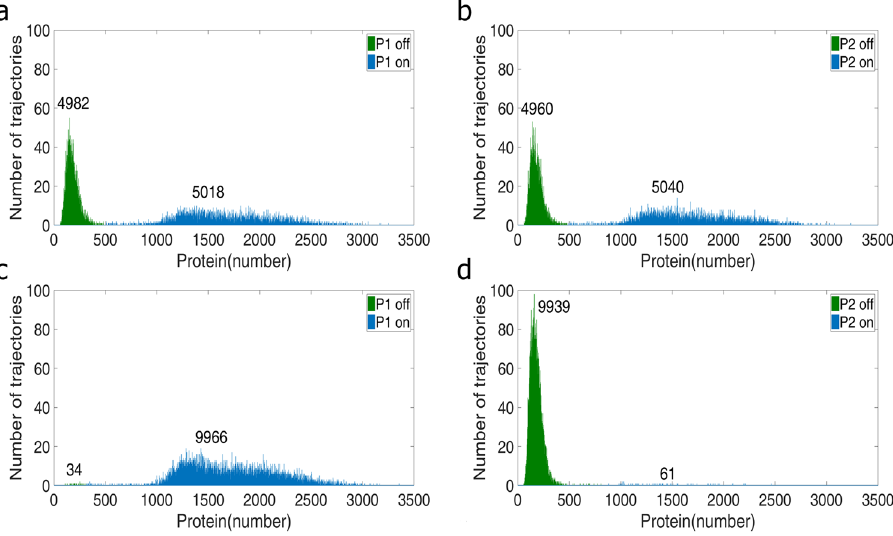
Figure 2. The bimodal distribution ( a ) and ( b ) are the stationary bimodal distribution of P1 and P2 monomers, obtained from parameters of nominal values. The number above each mode indicates the cell counts of the mode. The ON state is in blue color and OFF in green color. ( c ) and ( d ) are bimodal distributions with the transcription rate of gene X adjusted to 8 folds of the nominal value but that of gene Y is kept at the nominal value. The high level of the peptide X makes cells move to the ON state of P1 and OFF state of